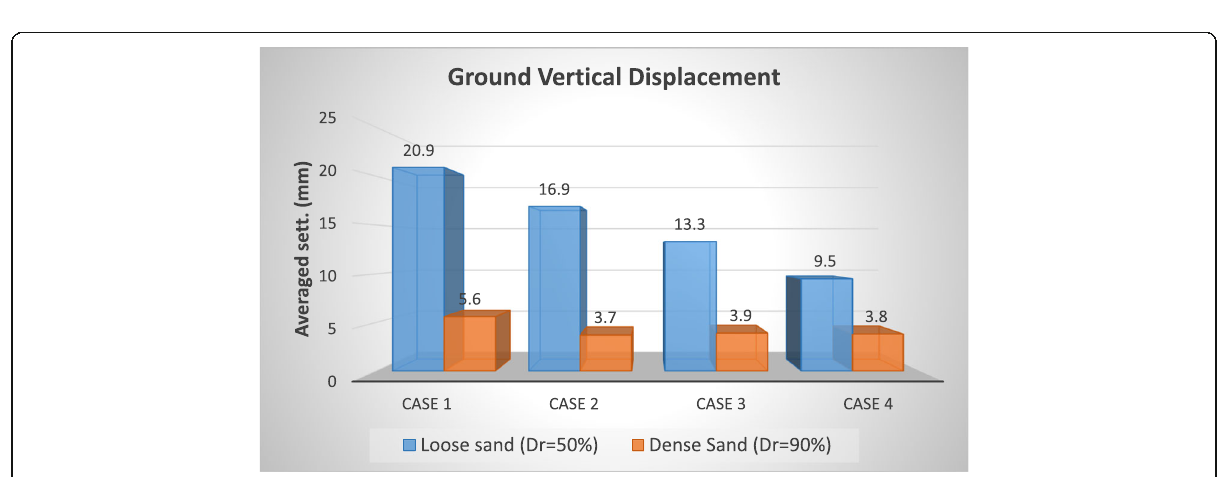
Fig. 9 Averaged ground vertical displacements